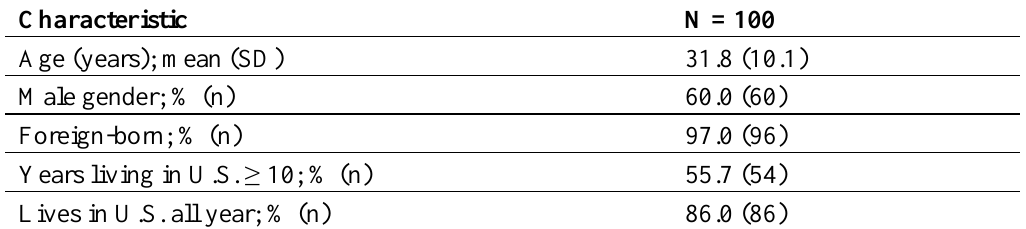
Table 1. Demographic and work characteristics among study participants, Oregon,